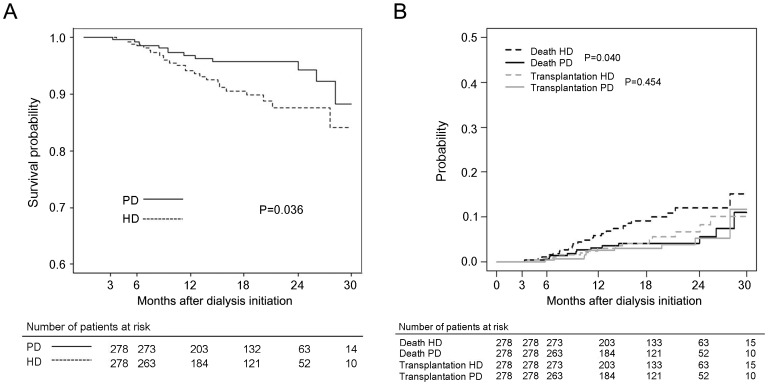
Survival probability from day 90 by dialysis modality and cumulative incidence curves for death and transplantation.(A) Propensity-score matching of patients. (B) Cumulative incidence curves for death and transplantation, taking competing risks into account.